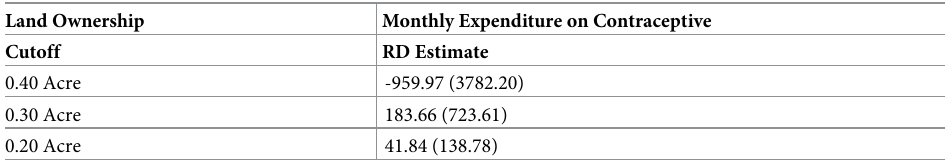
Table 6. RD estimates with placebo cutoffs.